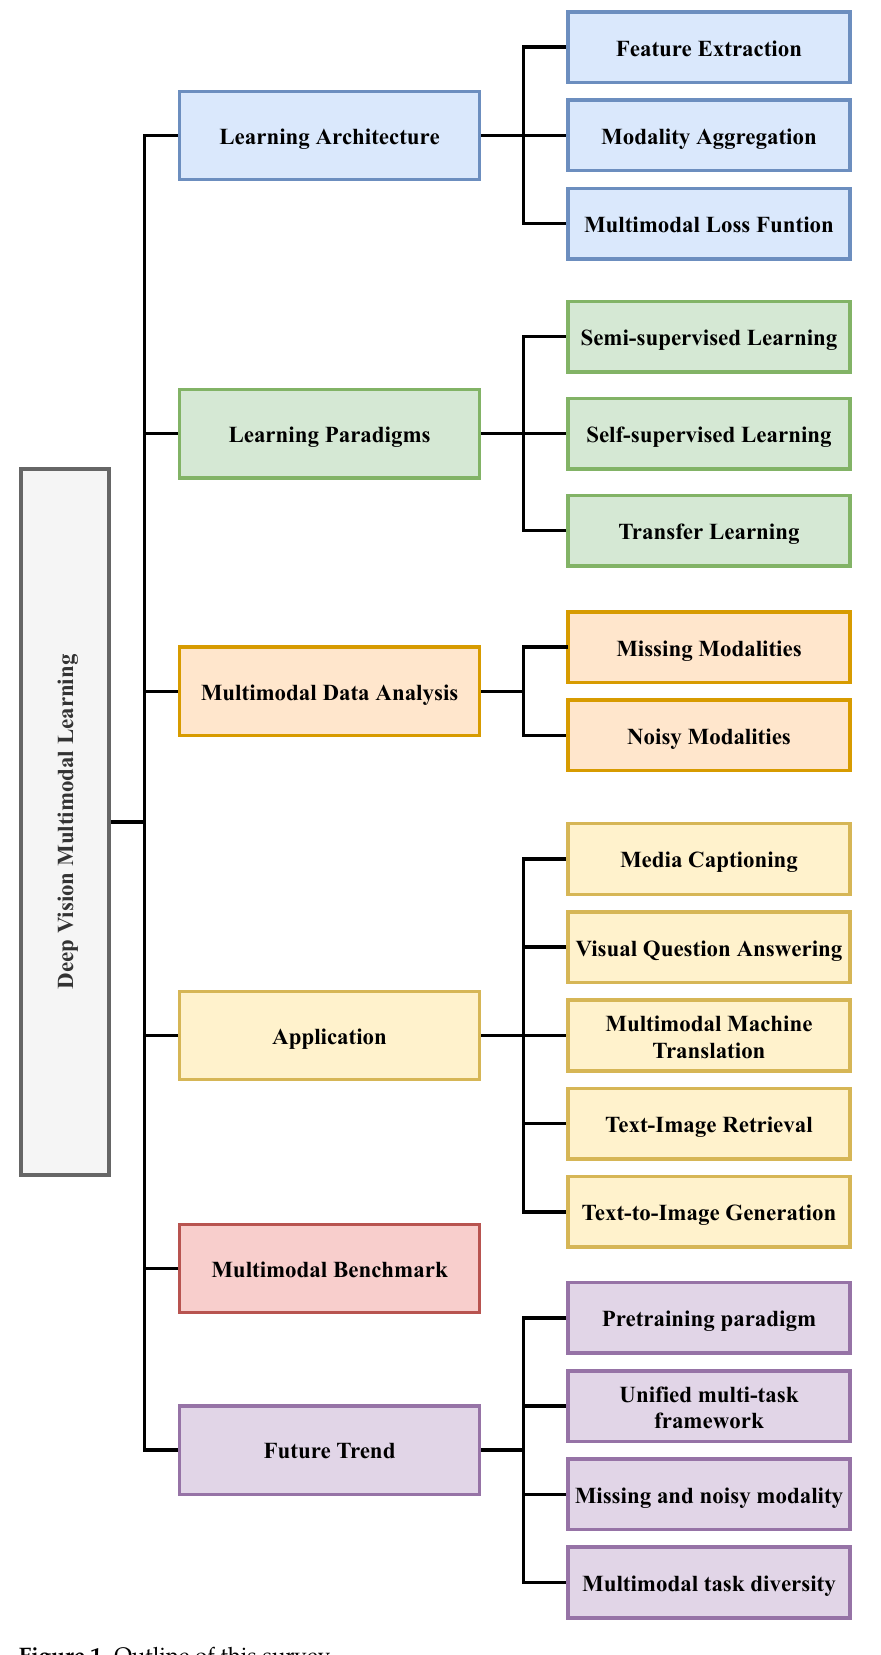
Figure 1. Outline of this